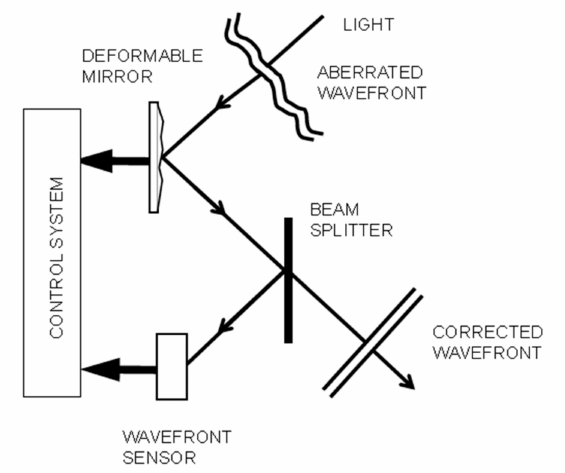
Figure 1. Concept of the working of an Adaptive Optics (AO)